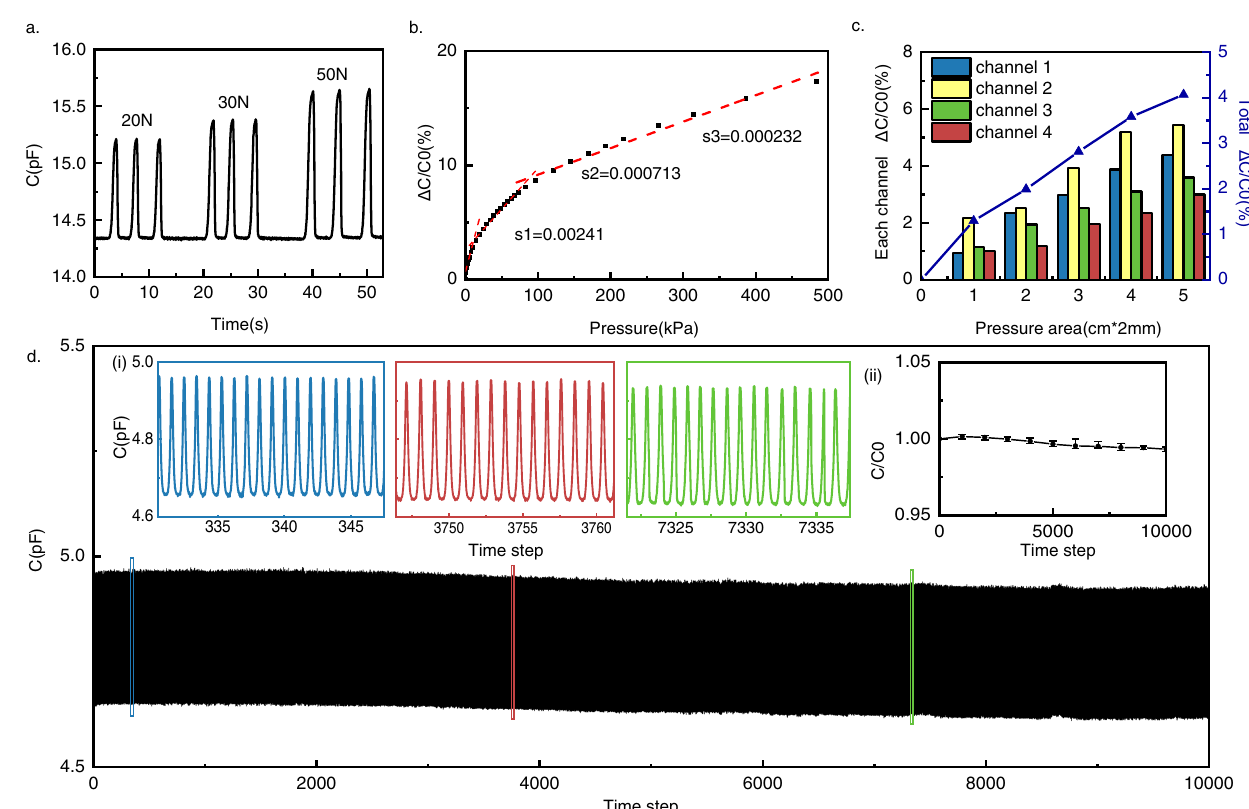
Fig. 2 | Characterization of braided electronic cord. a The capacitance response ofthebraidedelectroniccordfromatriplecompressreleasecyclesofcompression under forces of 20N, 30N, and 50N. b Relationship between relative change in capacitance and applied pressure of braided electronic cord. c Relationship between relative change in capacitance and applied contact area of the braided